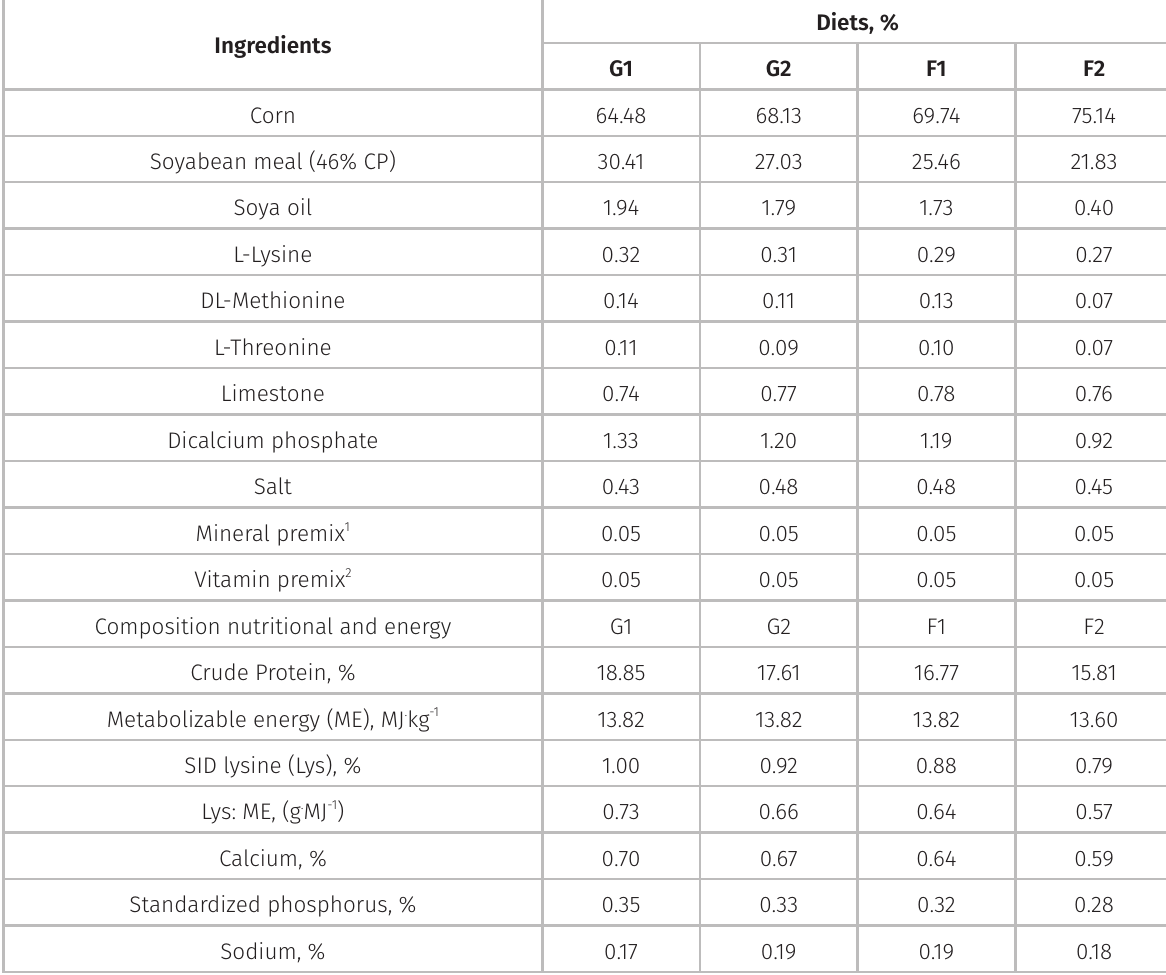
Table I. Composition and calculated nutritional values of the diets fed to pigs in the growing and finishing phases.